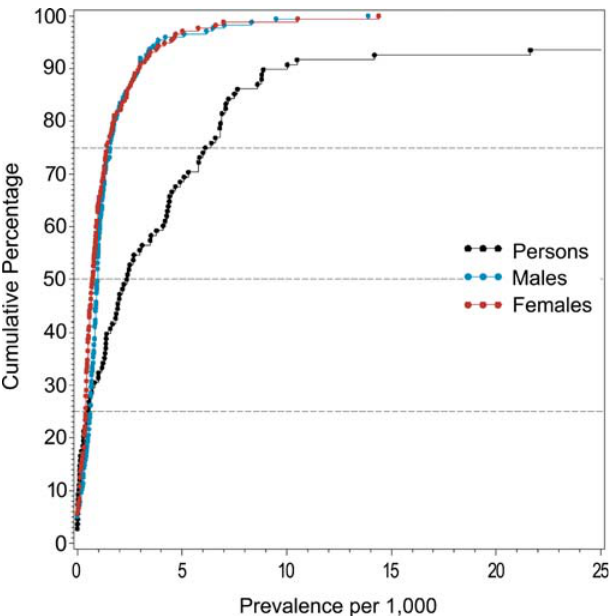
Figure 7. Cumulative Plots of the Inpatient-Census-Derived Prevalence Estimates per 1,000 by Sex DOI: 10.1371/journal.pmed.0020141.g007